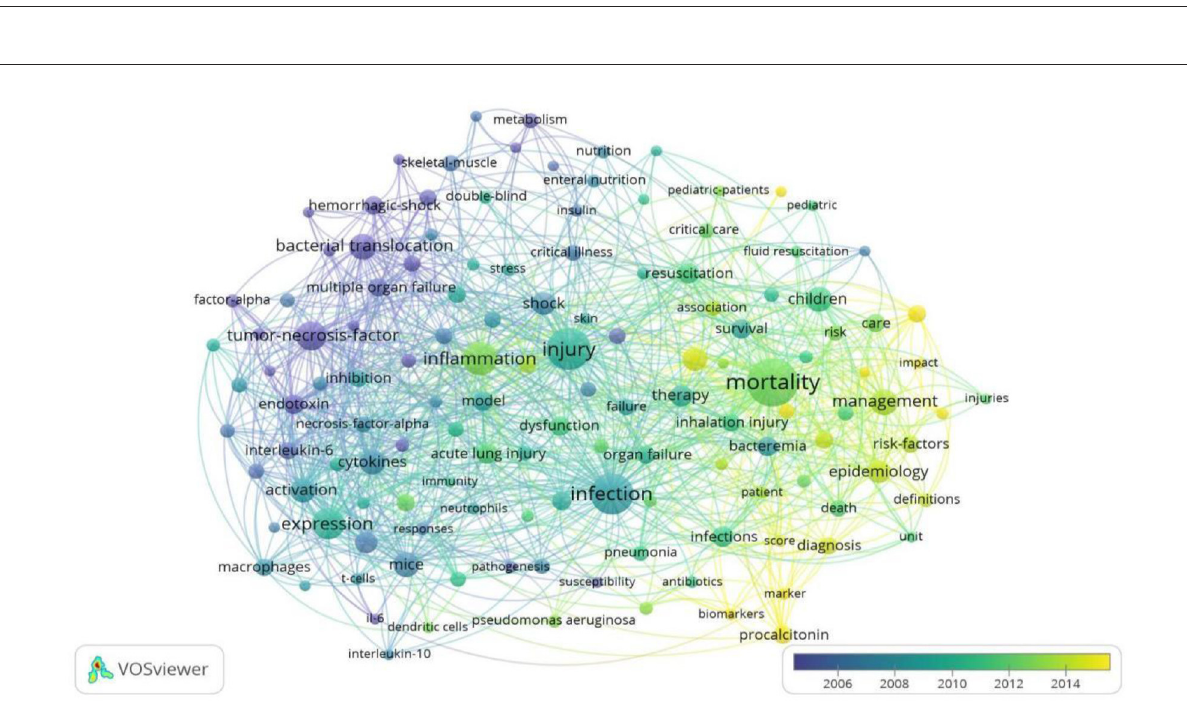
FIGURE7 Overlay visualization. Keywords are distributed according to the average time of occurrence. Blue represents the early keywords, and yellow represents the most recent ones. The smaller the distance between two keywords, the more frequently the keywords appear in the same literature